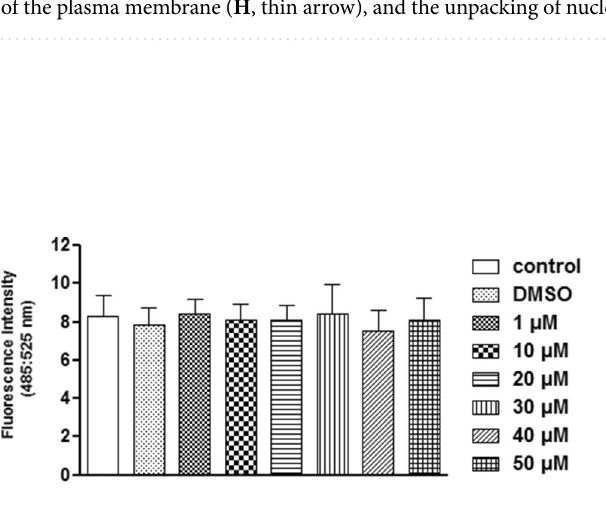
Figure 6. Neutral lipid quantification on T. cruzi epimastigotes in the presence of FEX for 72 h. The number of neutral lipids in treated and untreated parasites was similar. The data are the average of three independent experiments in